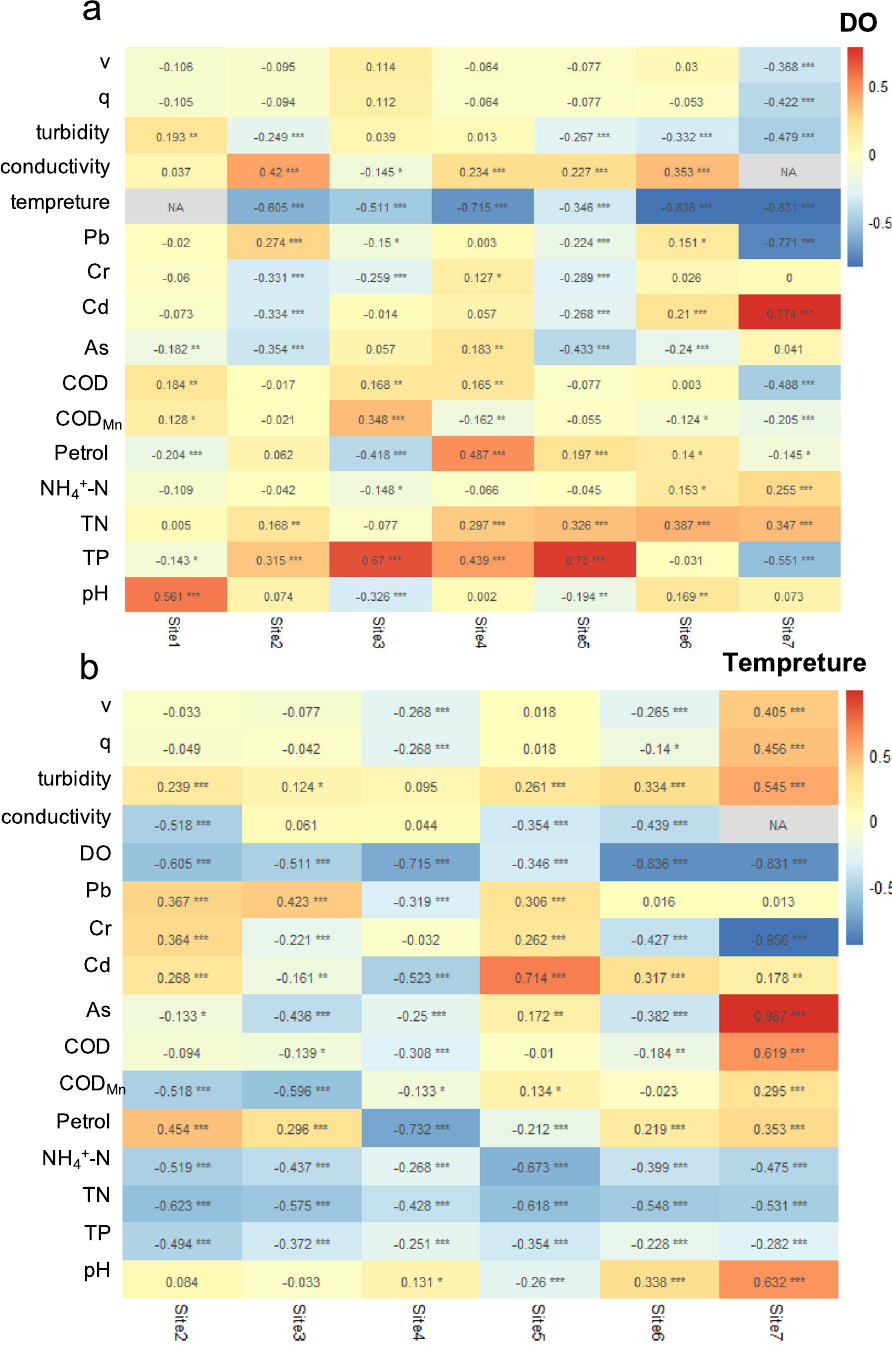
therefore, seasonal variations should be given full thoughts when selecting parameters to establish pollutant load reduction goals and the developing total maximum daily loads 2 . Indexes based on biological factors and physiochemical factors are two main types to assess polluted sta- tus in rivers and lakes 19,20 . CWQI in this study belonged to the latter type and predicted the risk of increased